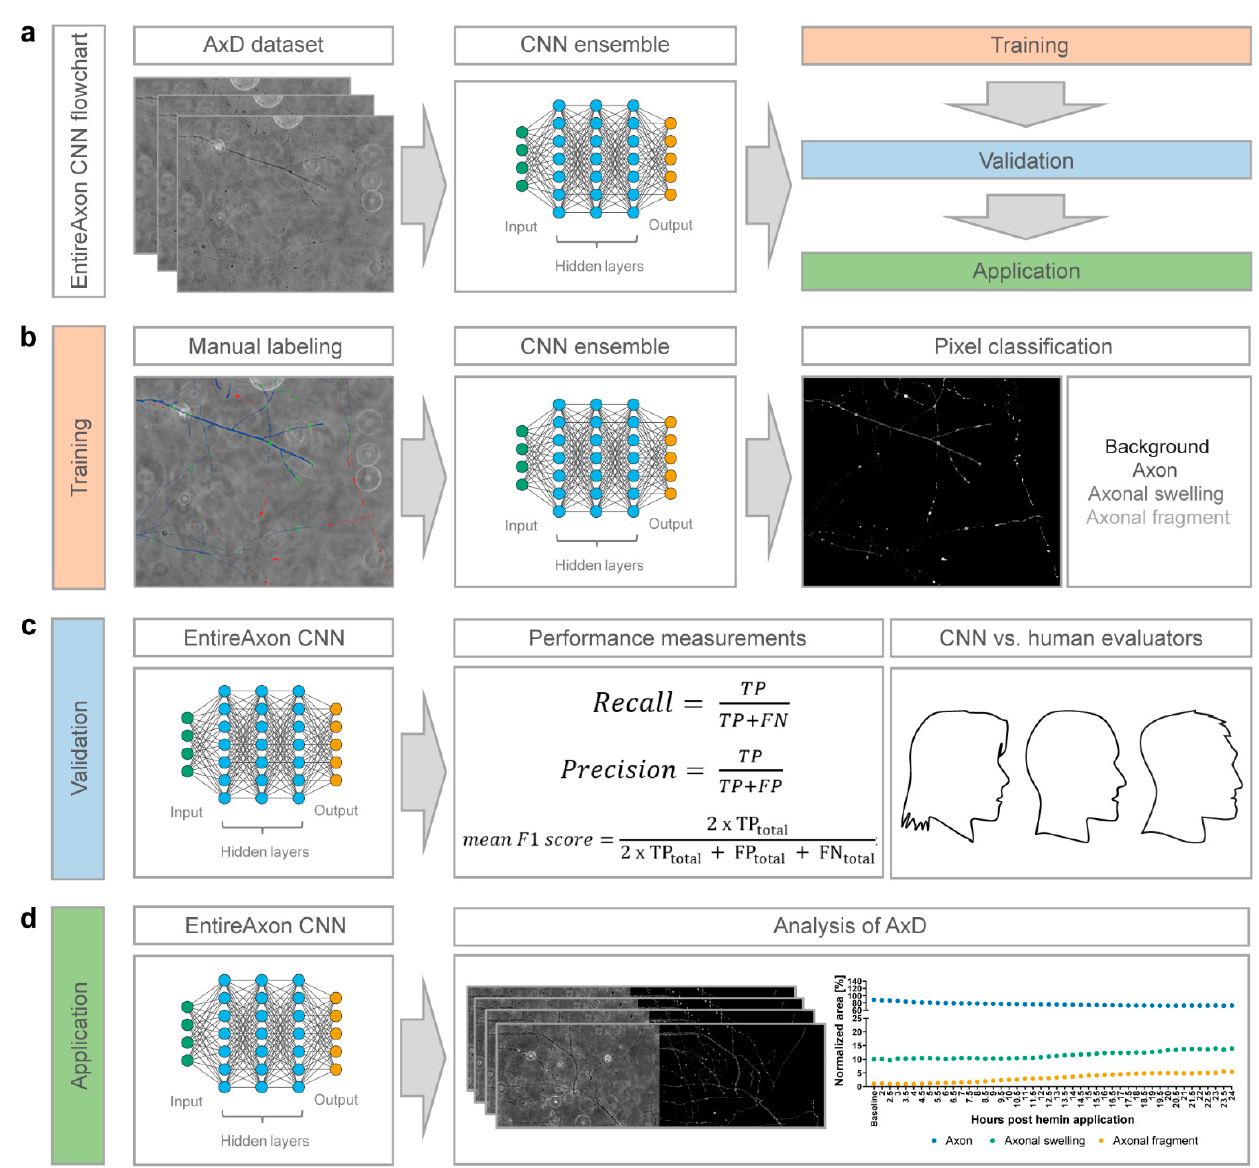
Figure 2. EntireAxon CNN for the enhanced throughput analysis of AxD. ( a ) The flowchart of the EntireAxon CNN. The AxD data was separated into training, validation, and testing data. We adapted a standard u-net with a ResNet-50 encoder and used a CNN ensemble, which combines the predictions from multiple CNNs to generate a final output and is superior to individual CNNs. ( b ) We manually labeled the training data to segment each pixel into the four classes ‘background’, ‘axon’, ‘axonal swelling’, and ‘axonal fragment’, which are displayed in the output image in black, dark grey, intermediate grey, and light grey, respectively. We trained an ensemble comprising eight CNNs to segment the four classes. ( c ) The EntireAxon CNN was validated with a separate validation dataset to assess its performance (recall, precision, and mean F1 score), which was compared to the human evaluators (ground truth was labeled by human evaluator 1). ( d ) The EntireAxon CNN was applied to data on AxD induced by the exposure of hemin, which is used to model of hemorrhagic stroke in vitro .